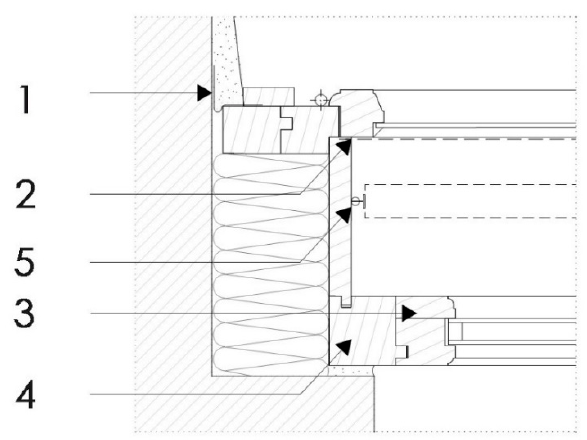
Figure 6. Installation detail of the combined window. 1: butyl tape between plastered surface and casement; 2: plane of sealing; 3: 55 / 23 mm glazing bead, 4: thicker frame and sash, 5: textile roller blinds.